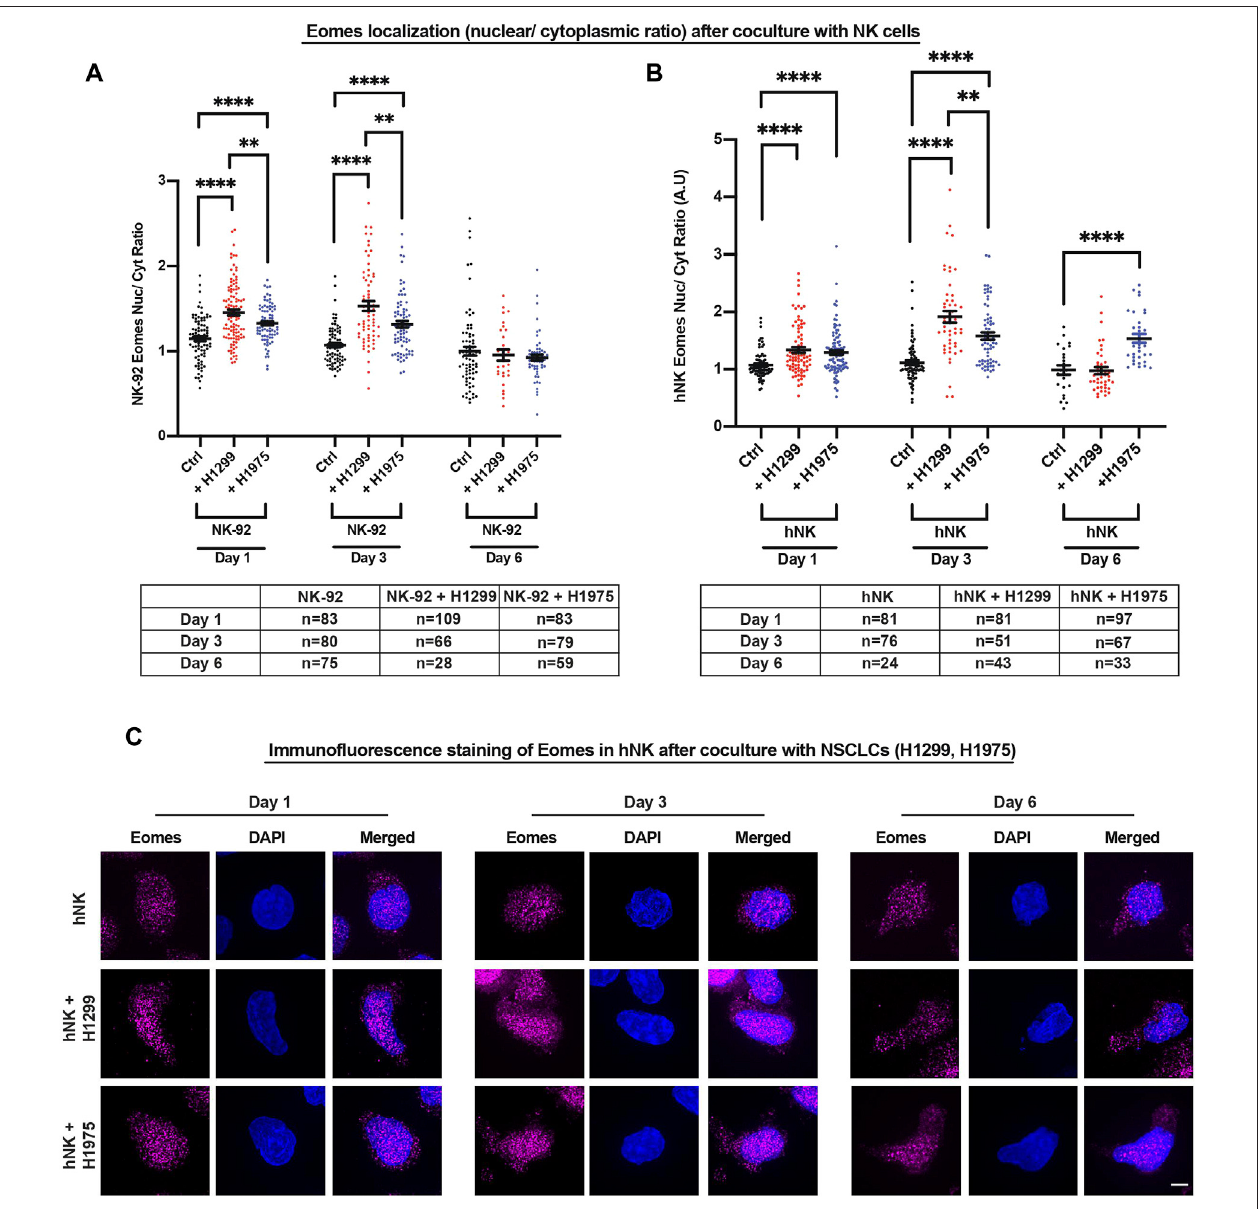
FIGURE 2 | NSCLCs induced nuclear localization of Eomes within 1 day in NK cells . (A,B) NK-92 and hNK cells cocultured with NSCLCs showed preferential nuclear localization of Eomes, particularly strongly on day 3 for NK cells cocultured with H1299 NSCLC. The graphs represent means ± SEM; n is tabulated below the graphs.ForhNKcells,nvaluesarerepresentativeofindividualcellsrepresentativeofthreedonors.OnewayANOVAwasusedtocomparethemeansofeachgroup. (C) Representative SIM images of Eomes in hNK cocultured with NSCLCs. Increasing nuclear (DAPI stained) Eomes signal (magenta) is detected in hNK cocultured with NSCLCs. Scale bar = 5 μ